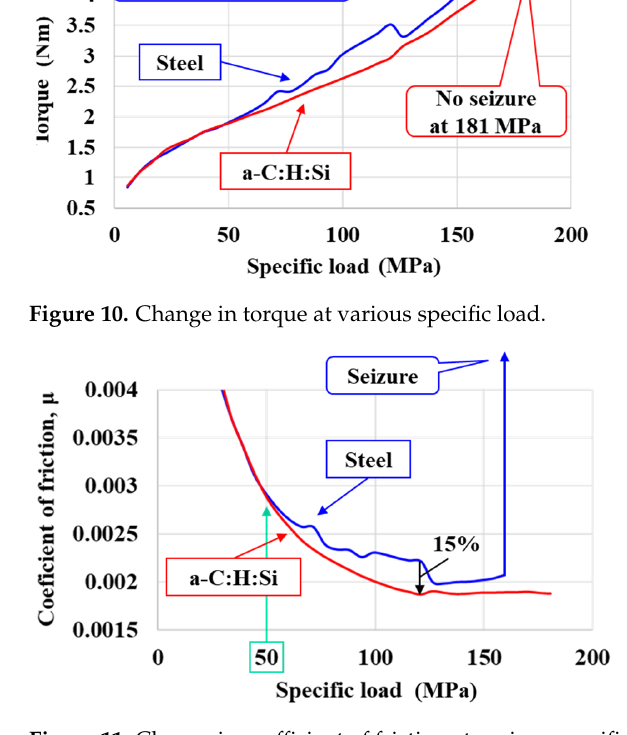
Figure 11. Change in coefficient of friction at various specific load.